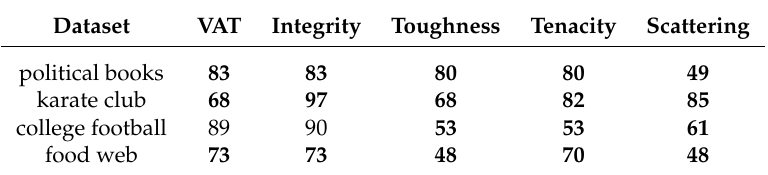
Table 1, VAT, integrity, toughness and tenacity all achieved accuracies of 80% or higher on this dataset. Both Girvan–Newman and Louvain modularity attained a clustering accuracy of 84%. Table 1. Percent accuracy for real data in native graph form. Bold text indicates one-step clustering. Dataset